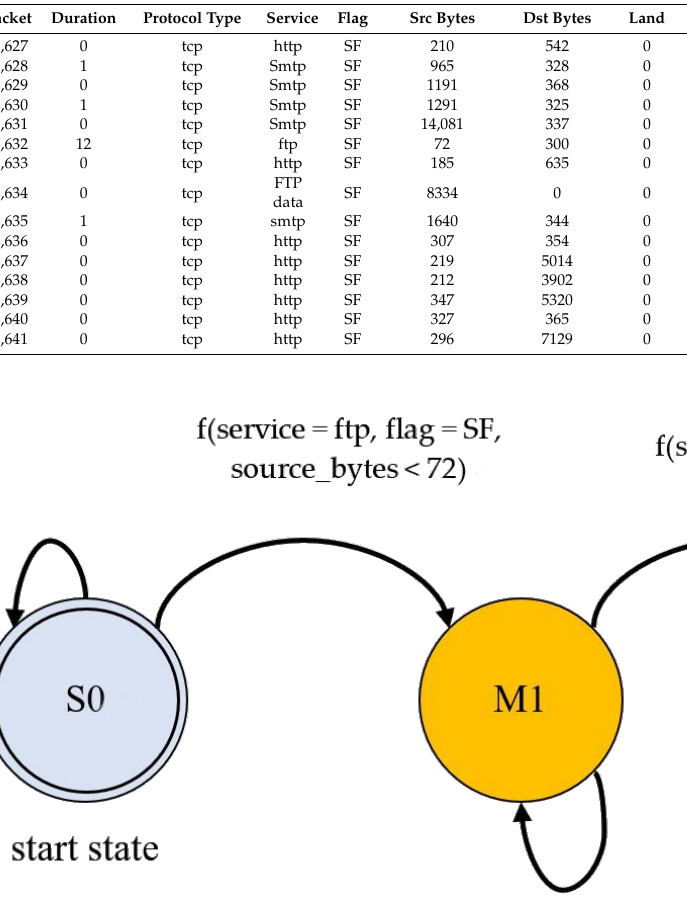
Figure 2. An illustration explaining the mechanism of state transition for detecting warezmaster among irrelevant packets. At beginning, a suspicious attack is detected, f(service = ftp, flag = SF, source bytes < 72), but the attack activity cannot be certain completely. Therefore, state M1 is entered and the next state will be determined by further information. If sufficient evidence is observed, f(service = ftp data, flag = SF, source bytes >8334), state A1 is entered and the attack is captured